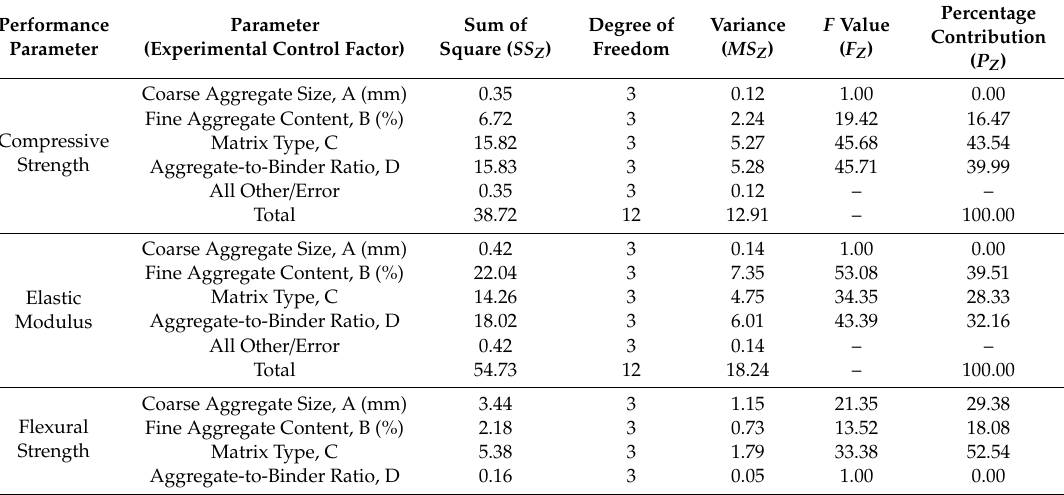
Table 14. Variance analysis and F test for pervious concretes.